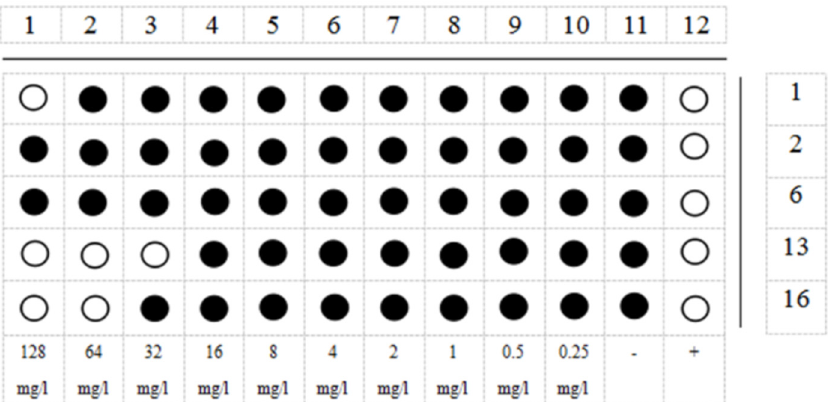
Figure 8. The schematic diagram of a 96-well plate measuring MIC (data taken from three parallel experiments). Horizontal direction is AMP 1, 2, 6, 13, 16 test rows; Vertical direction 1–10 is the final concentration of 128 mg/L to 0.25 mg/L of these AMPs, respectively; 11 is the negative control; 12 is a positive control, the 20 mg/L ampicillin.